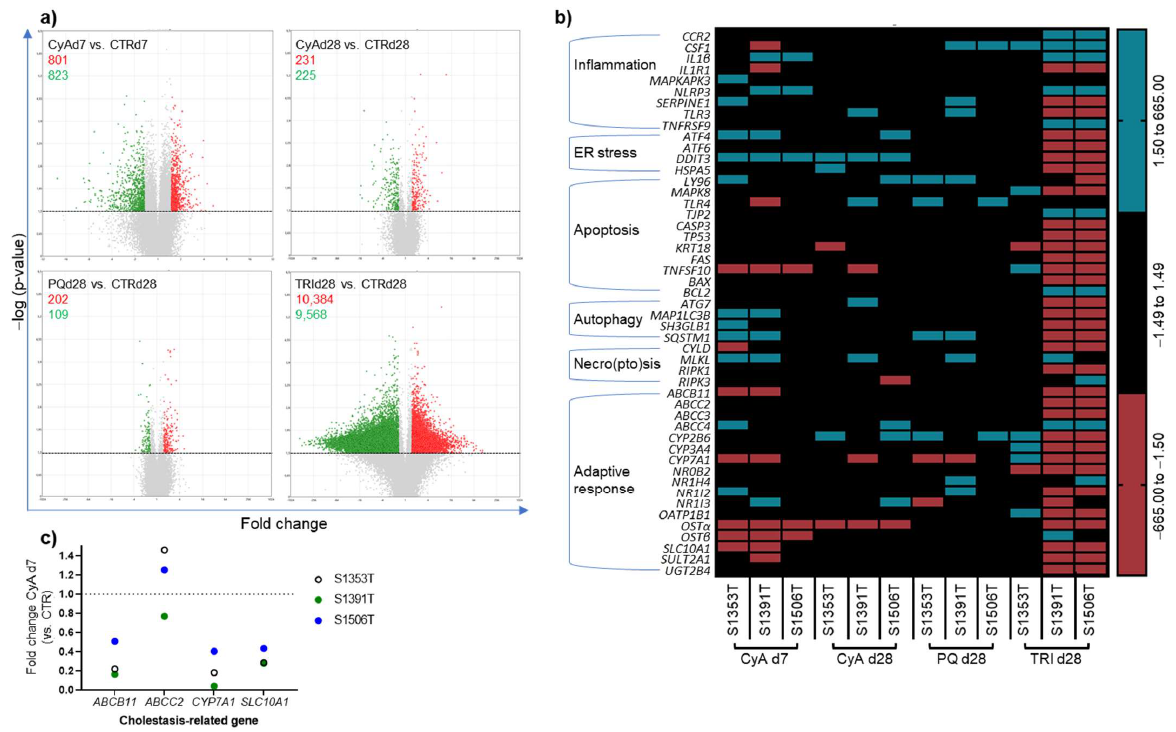
Figure 4. Transcriptomic analysis of PHH spheroids exposed to CyA 5 μM, PQ 2 μM and TRI 100 μM during 7 and/or 28 days. ( a ) Volcano plots displaying the differentially expressed genes between treated spheroids and the respective control, considering all donors. Significance was set at absolute fold changes above 1.5, with a p -value below 0.05 and an FDR p -value below 1, calculated via one-way ANOVA followed by post hoc tests using Bonferroni’s correction and Benjamini–Hochberg correction (green: downregulation; red: upregulation). ( b ) Heat-map displaying donor-by-donor compliance with the AOP on drug-induced cholestasis. At least 75 spheroids were used per donor and per condition. Absolute fold changes above 1.5 were considered significant. ( c ) RT-qPCR results confirming the effects of a 7-day exposure to CyA 5 µ M on genes encoding canalicular transporters ABCB11 (BSEP) and ABCC2 (MRP2), uptake transporter SLC10A1 (NTCP), and CYP7A1, the main enzyme involved in BA synthesis and homeostasis. All the gene names are listed in Table S2 in